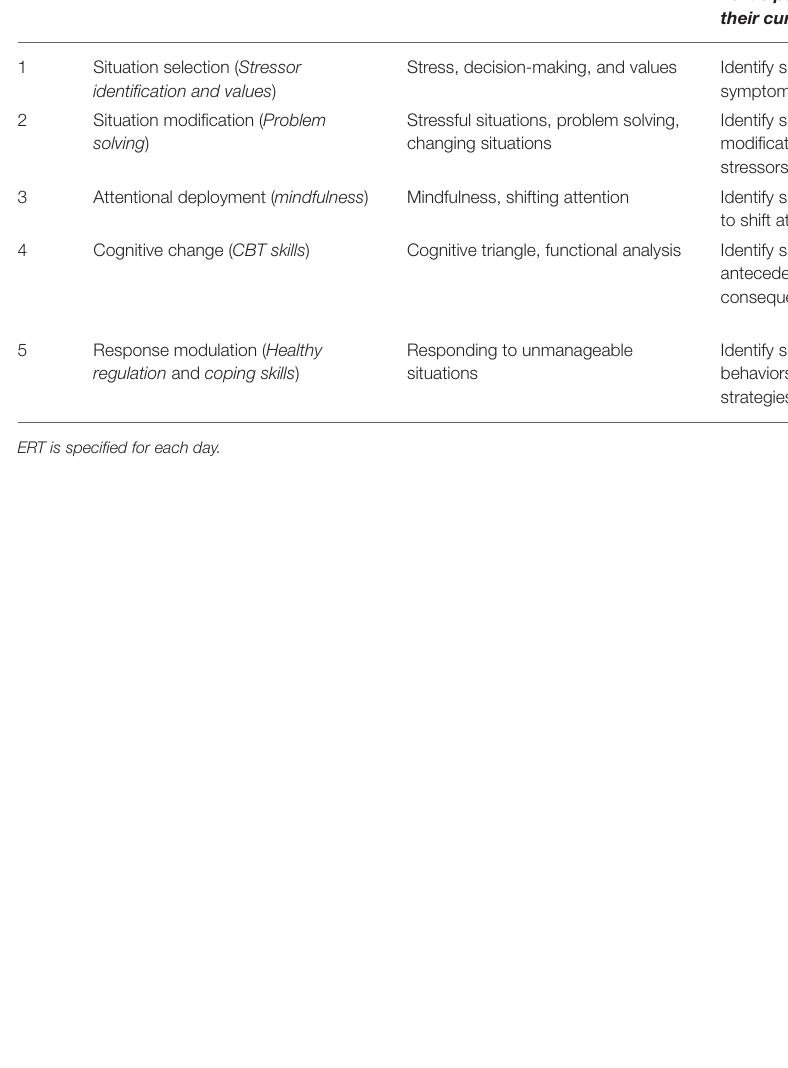
TABLE 1 | Daily emotion regulation training (ERT) program content is outlined below. Week Gross (24) Model ( Content area ) Psychoeducation Foundational information provided in the following